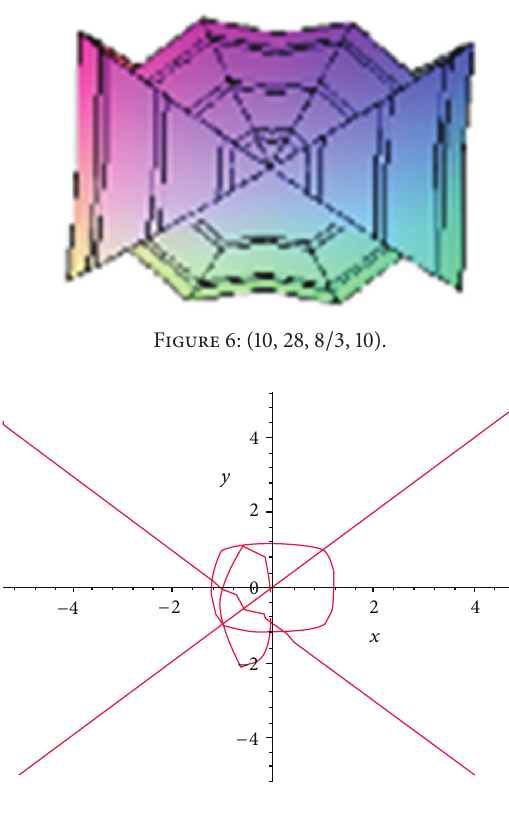
Figure 7: The phase plane of 𝑝 0